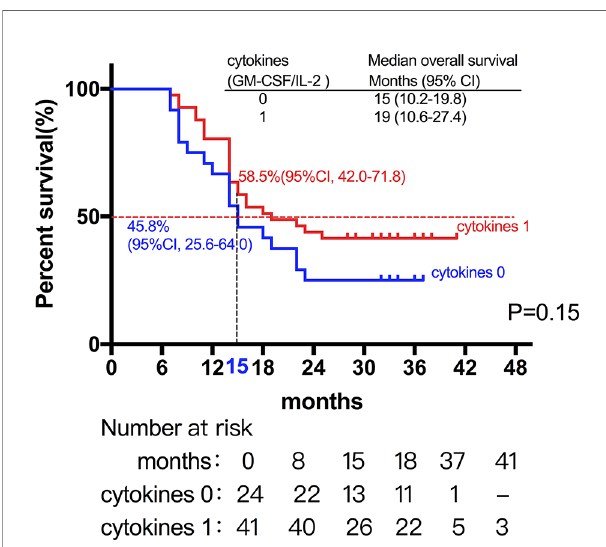
FIGURE 6 | The prognosis of patients receiving cytokine treatment (GM- CSF/IL-2) in combination with radiotherapy was better than that of patients treated with radiotherapy alone, while there was no statistical difference (19 vs . 15 months, P=0.15).